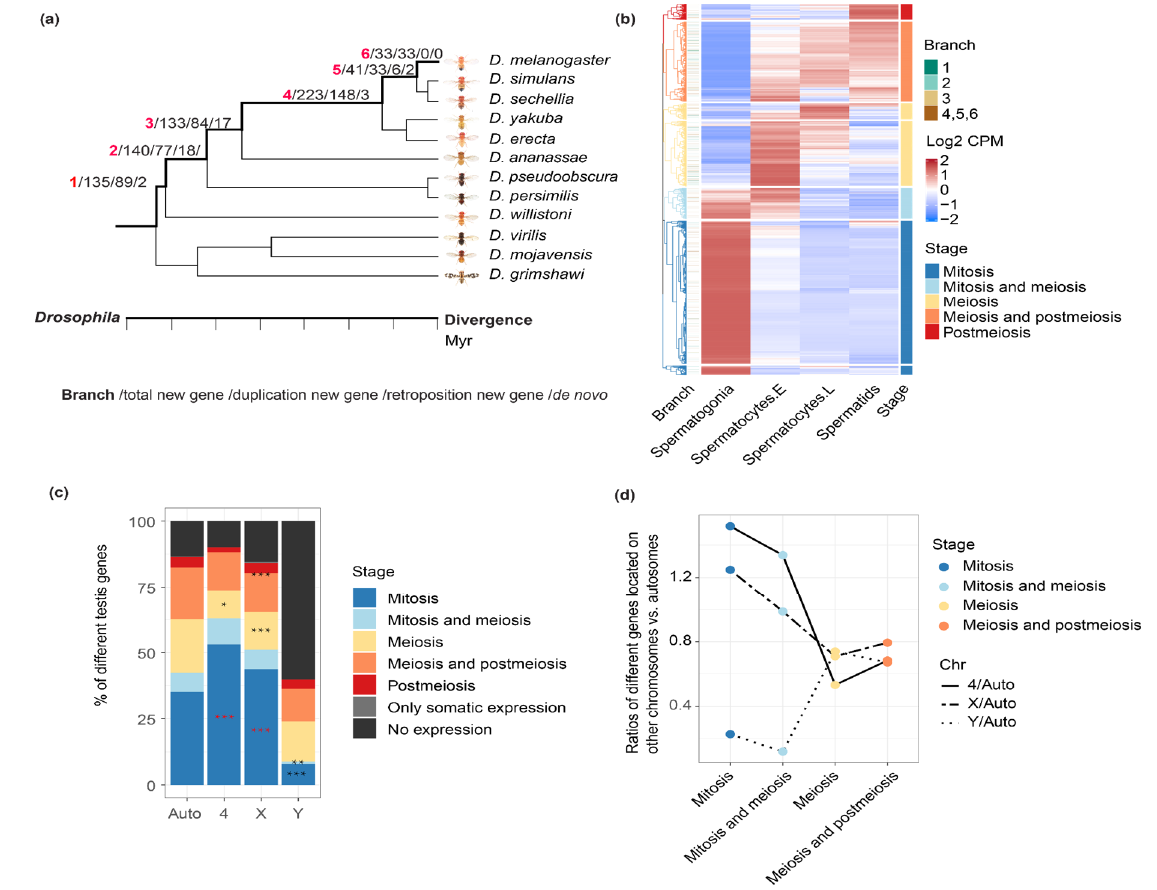
Figure 1. Comparing chromosomal distribution of genes across stages of spermatogenesis. ( a ) The number of new genes divided by branches and origination mechanisms, the description of each number separated by slash is shown in the bottom, the divergence time of each branch is also shown in the plot with number 1 to 6. New genes of branch 6 are the youngest new genes and only restricted to Drosophila melanogaster. New genes of branch 5 are shared by D. melanogaster , D. simulans and D. sechellia and ‘older’ than those of branch 6, and so on. ( b ) Unsupervised clustering of testis-expressing genes according to their average expression level within each of the four types of cells (spermatogonia, early spermatocytes, late spermatocytes and spermatids). Each line is a gene, and each column shows the color scaled normalized expression level, i.e., the log2(CPM + 1) value per gene within a testis cell type. The genes are then divided into 5 categories based on their predominant expressed cell types as mitotic genes, meiotic genes, postmeiotic genes or genes that span two adjacent stages. We also show the branch information of new genes next to the heatmap, with most genes shown in white color as they are old genes shared by all Drosophila species. ( c ) The distribution of different categories of genes in autosomes, 4, X and Y chromosomes. The black asterisks mean significant underrepresentation when being compared with autosomes, whereas the red asterisks means significant enrichment. Since there are few post-meiosis genes, we combine them with meiosis genes when performing the statistical tests, and the asterisks are shown between the orange and red. ( d ) Each dot shows the ratio of numbers of genes on the X/Y/dot chromosome vs. autosomes within each cell category. “*”: p < 0.05, “**”: p < 0.01, “***” p <